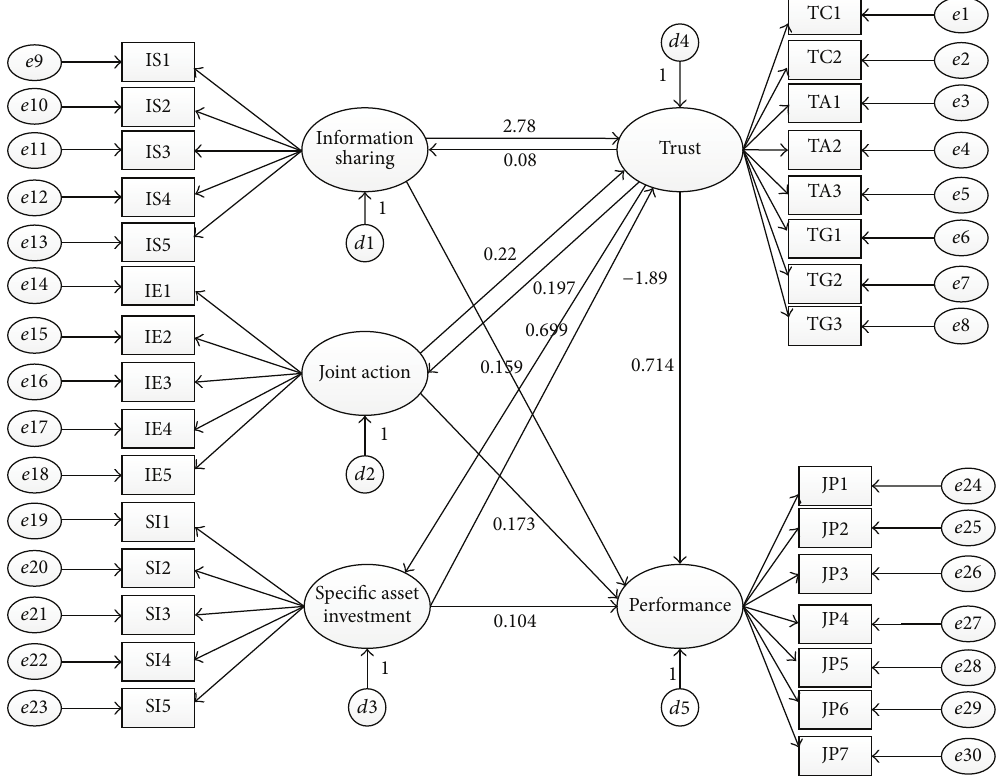
Figure 2: The path analysis diagram.